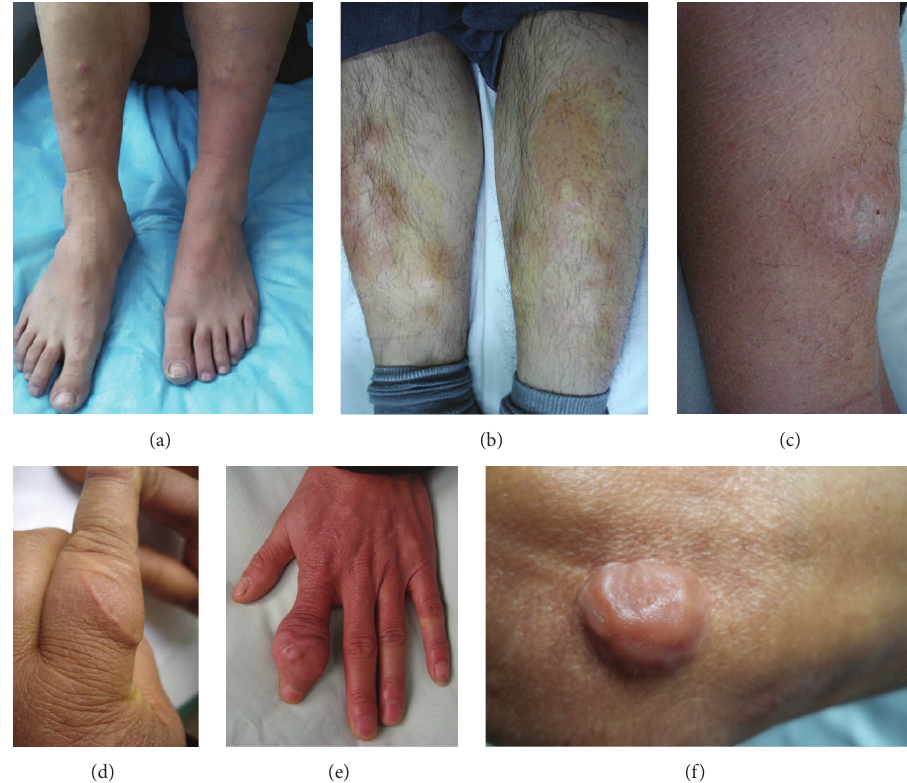
Figure 1: Nodule variant. (a) Multiple skin-color nodules on the extensors of lower legs. (b) Multiple red nodules on the extensors of lower legs. (c) A single scaly and erythematous nodule on the extensor of left lower leg. (d) A single, poorly defined and skin-color nodule at the traumatic scar of left proximal index finger. (e) A single, ill-defined, and skin-color nodule at the scar of left distal index finger. (f) A single, well-circumscribed, and keloid-like nodule at the scar of right elbow.